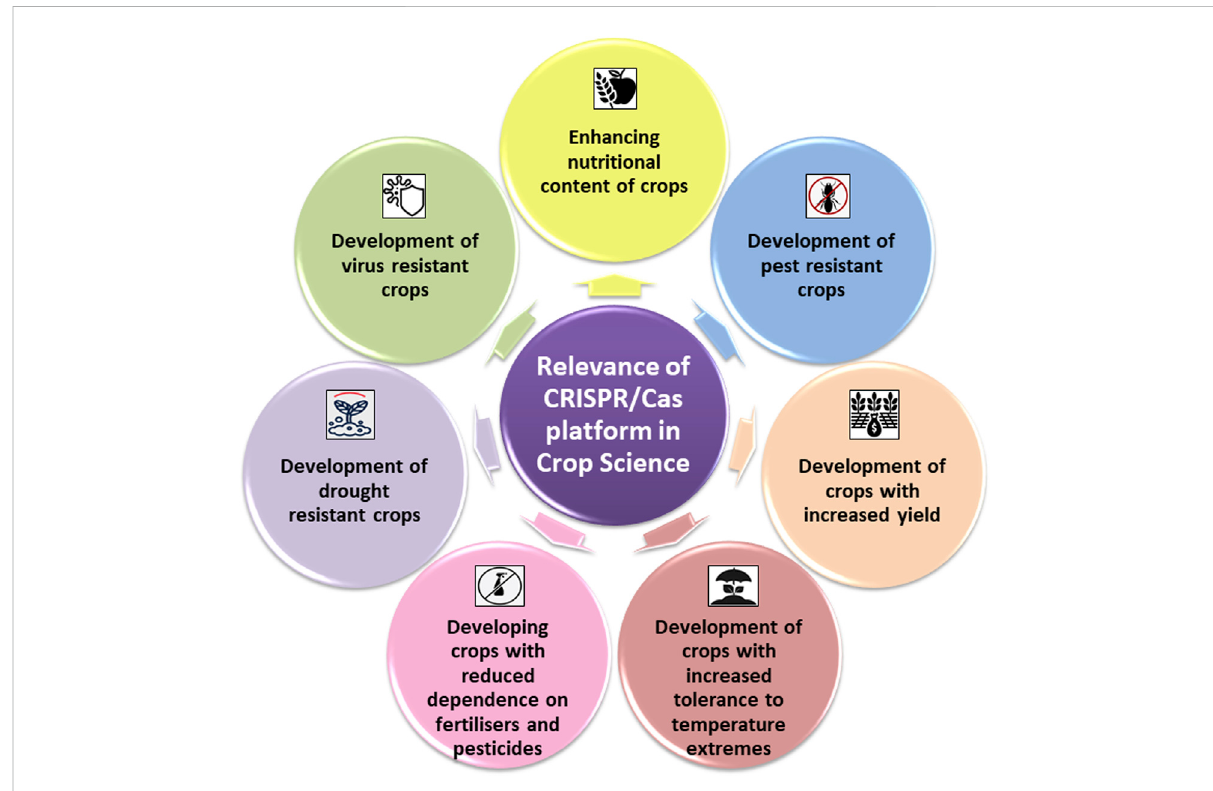
FIGURE 2 Schematic representations of the domains of crops sciences wherein CRISPR/Cas platforms have largely